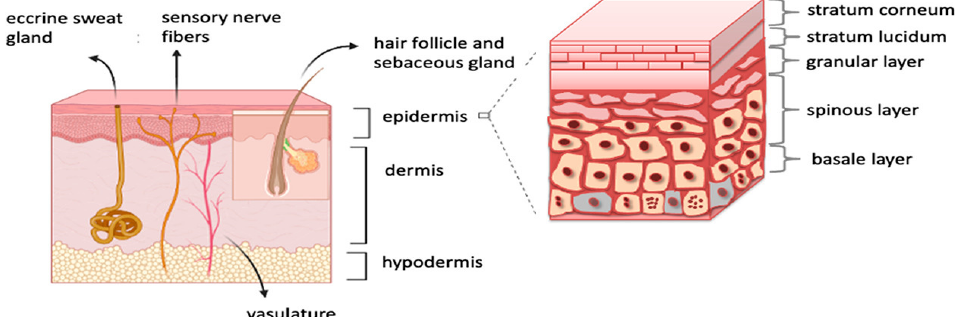
Figure 1. The cross-section of skin layers and the epidermis.